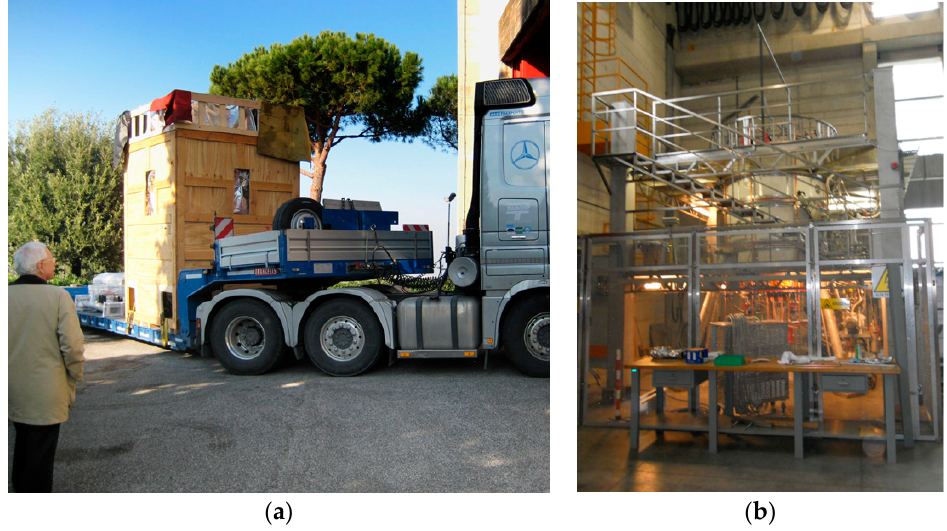
Figure 6. ( a ) Arrival of the modified START vacuum vessel in Frascati in 2010; ( b ) Present aspect of the vessel in the ENEA Research Center.